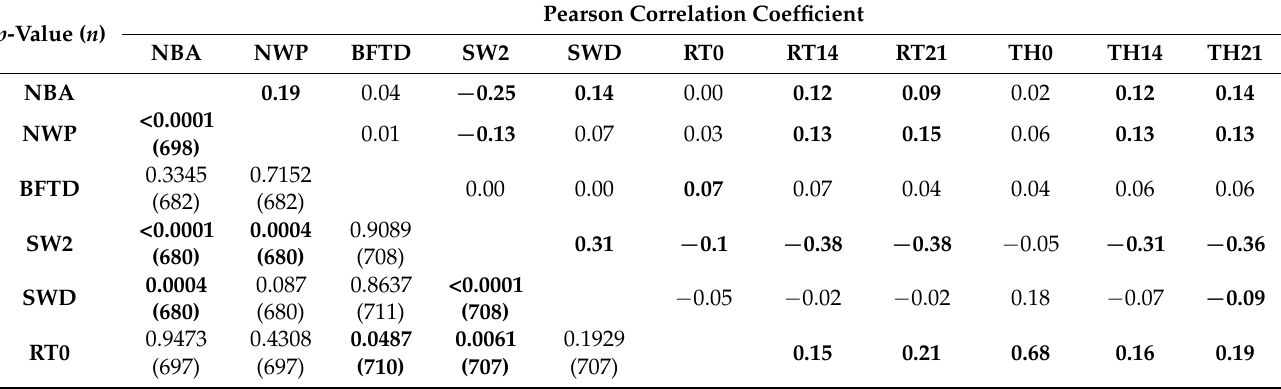
Table 5. Pearson correlation coefficient between rectal temperature, thermographic temperature of the mammary glands and performance parameters while different time